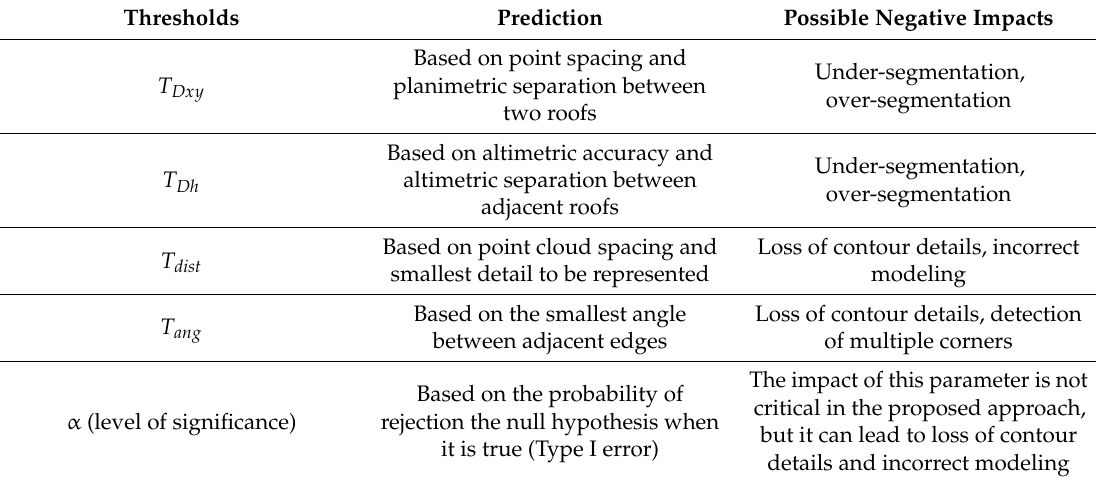
Table 2. The proposed method’s thresholds, their prediction, and possible negative impacts. Thresholds Prediction Possible Negative Impacts